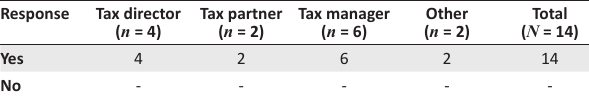
TABLE 7: Results of the meaning of the term ‘anticipated’. Response Tax director ( n = 4)